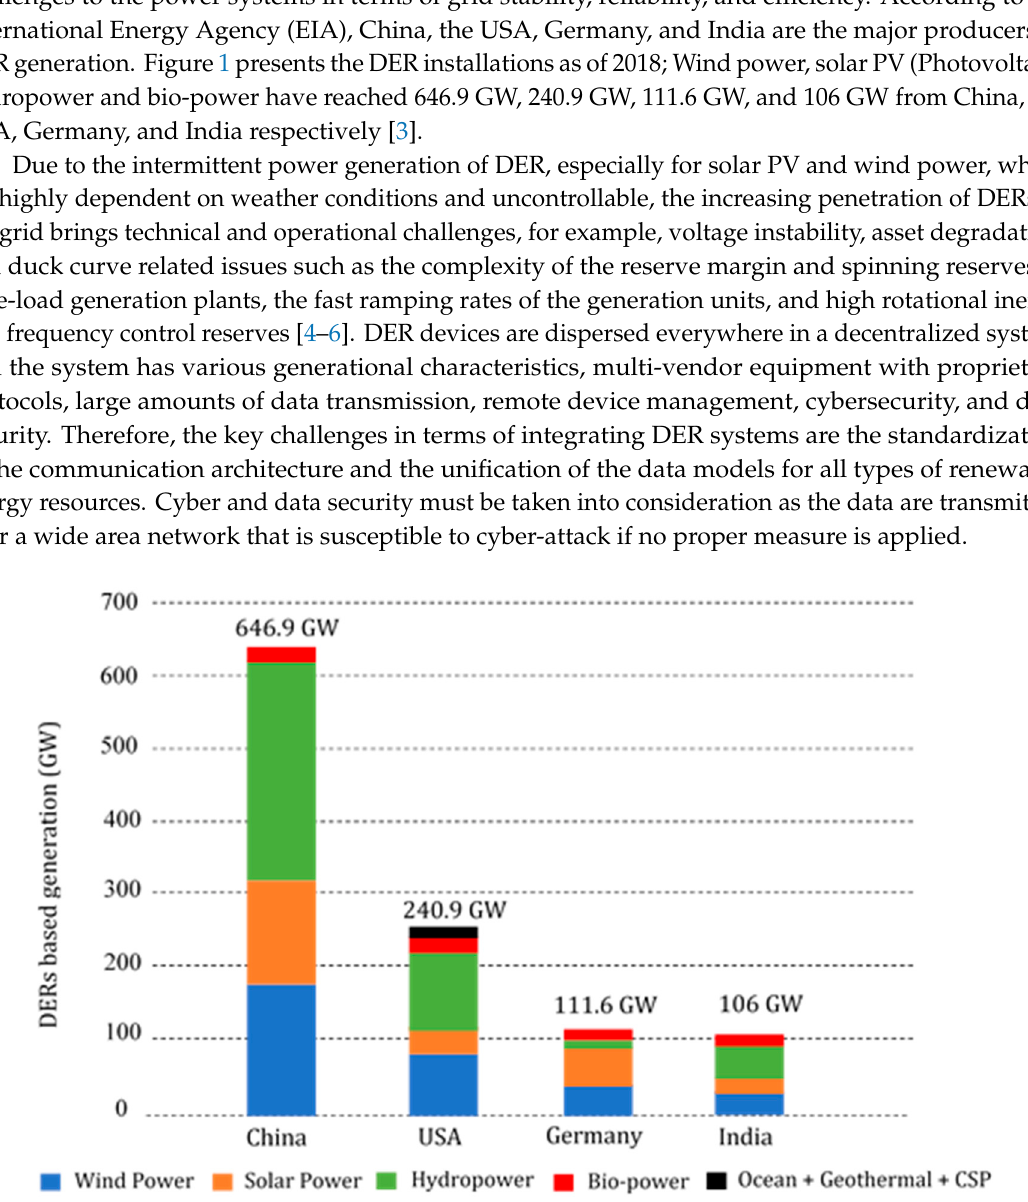
Figure 1. DER-based generation of top four countries as of 2018.